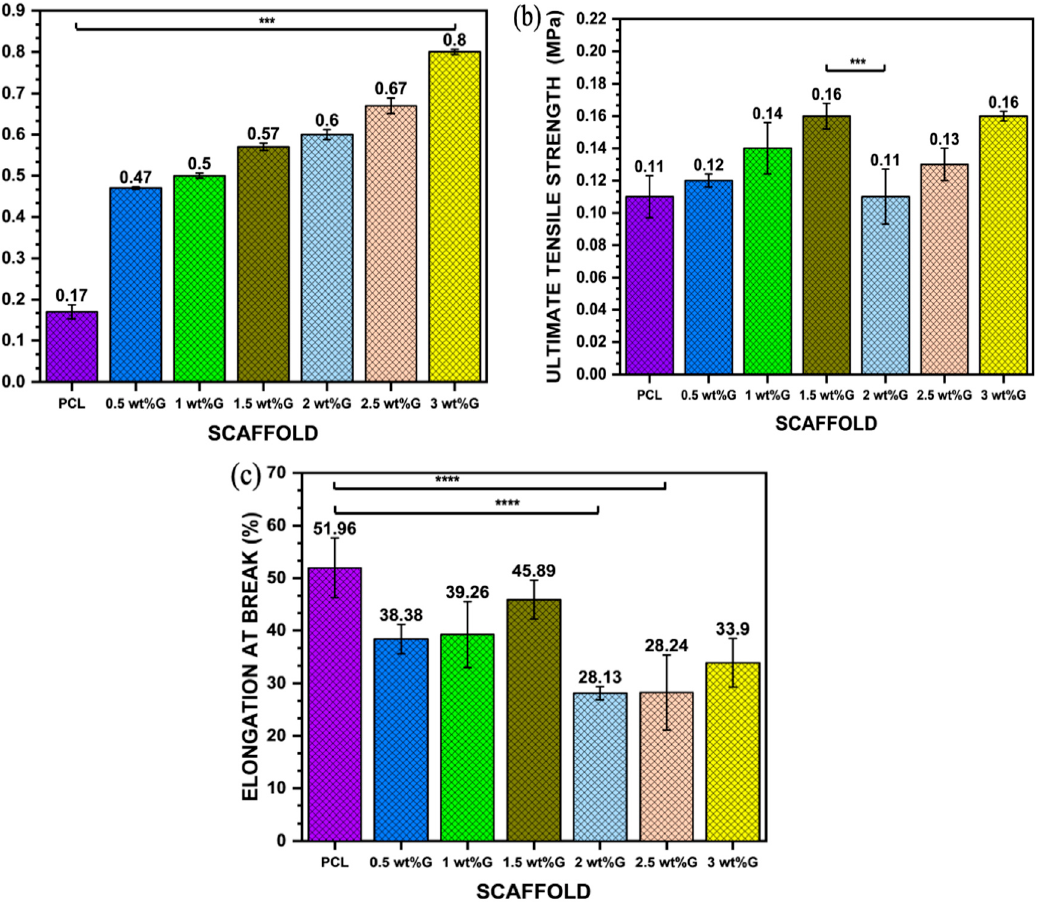
Figure 4. Mechanical properties: ( a ) Young’s modulus value of PCL/G scaffold; n = 3; *** p < 0.001. ( b ) Ultimate tensile strength ( σ max ) of PCL/G scaffold; n = 3; *** p < 0.001. ( c ) Elongation-at-break ( ε b ) of PCL/G scaffold; n = 3; **** p < 0.0001.